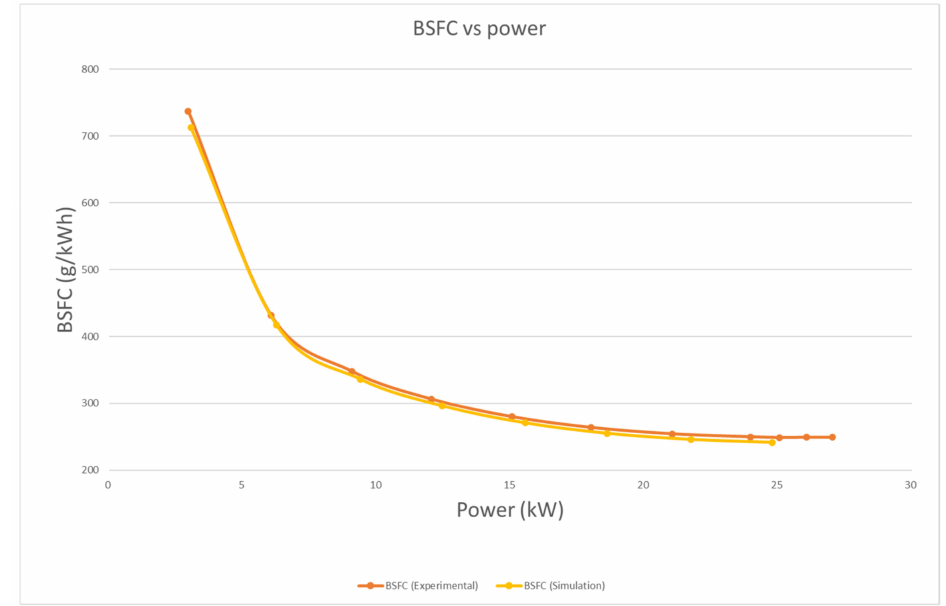
Figure 3. BSFC vs.